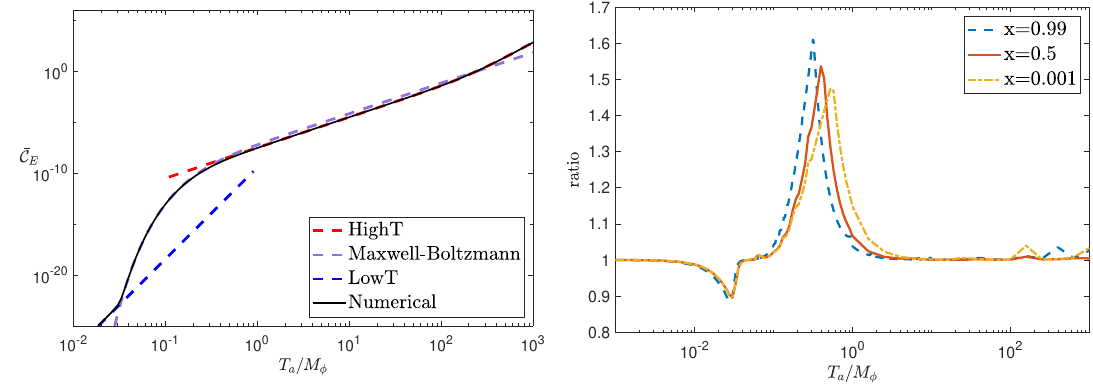
Figure 15. Left Panel: energy transfer collision term C E =M 5 as a function of T a =M (cid:30) for (cid:12)xed (cid:30) x = T b =T a = 0 : 5. The black solid line corresponds to C E numerically evaluated using eq. (C.12) and scattering amplitude as given in eq. (C.28), the red dashed line corresponds to C high-T (eq. (C.32)), the purple dashed line corresponds to C MB (eq. (C.35)) and the blue dashed line corresponds to C low-T (eq. (C.36)). Right Panel: ratio of the analytic approximation to the total collision term as given in eq. (C.37) to the numerical value as a function of T a =M (cid:30) for (cid:12)xed temperature ratios T b =T a = x = 0 : 99 ; 0 : 5 ; 0 : 001. Results are shown for y a = 0 : 01, y b =y a = 0 : 5, and m a;b = 10 (cid:0) 8 M (cid:30)